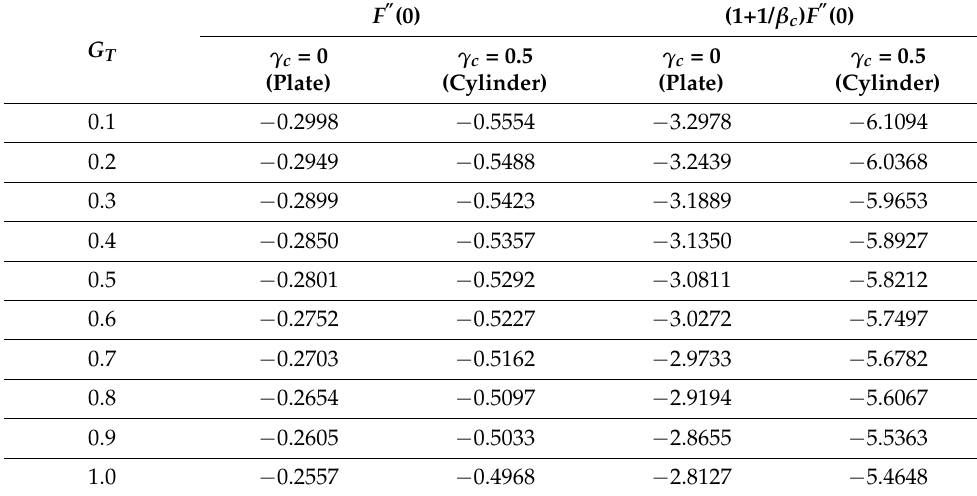
Table 9. Variation in SFC for G T [21].